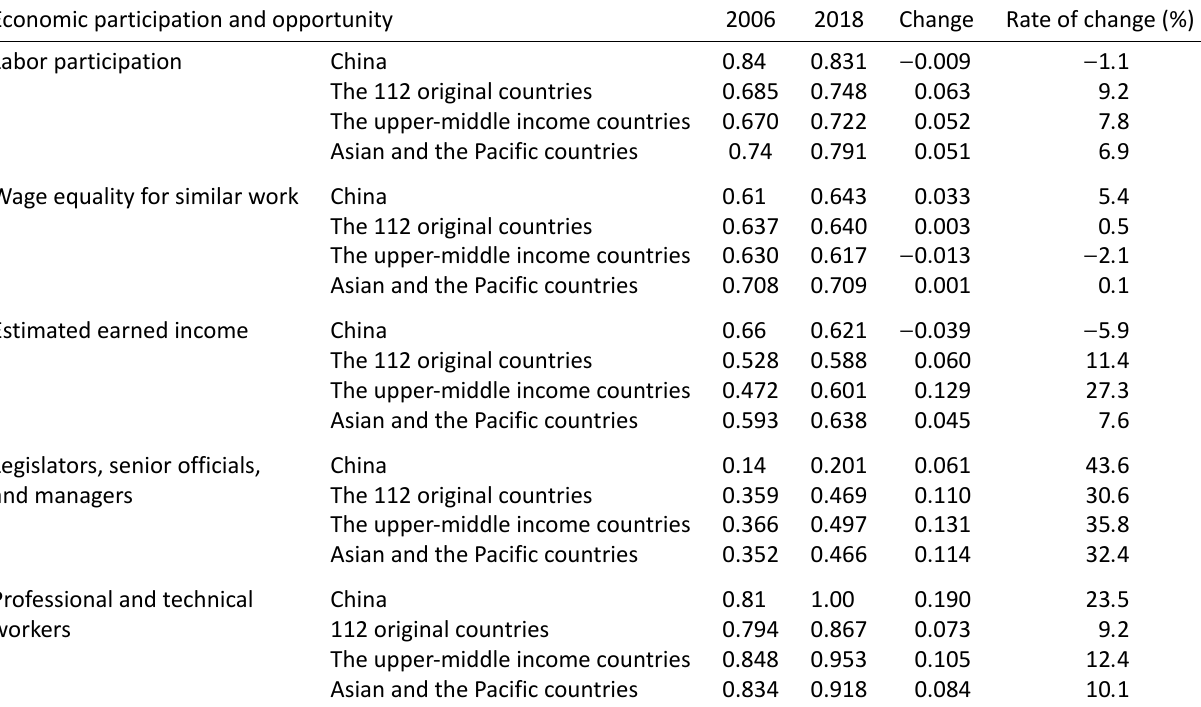
Table 3. Comparison of the scores of China and other countries in economic participation and opportunity. Economic participation and